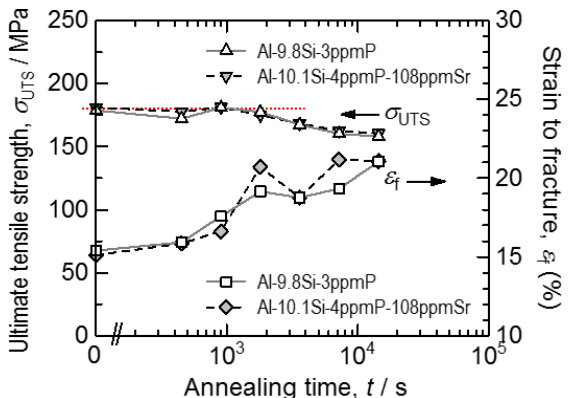
Figure 4. Stress-strain curves of tensile test in ( a ) Al-9.8%Si-3ppmP cast alloy and ( b ) Al-10.1%Si-4ppmP-108ppmSr cast alloy.